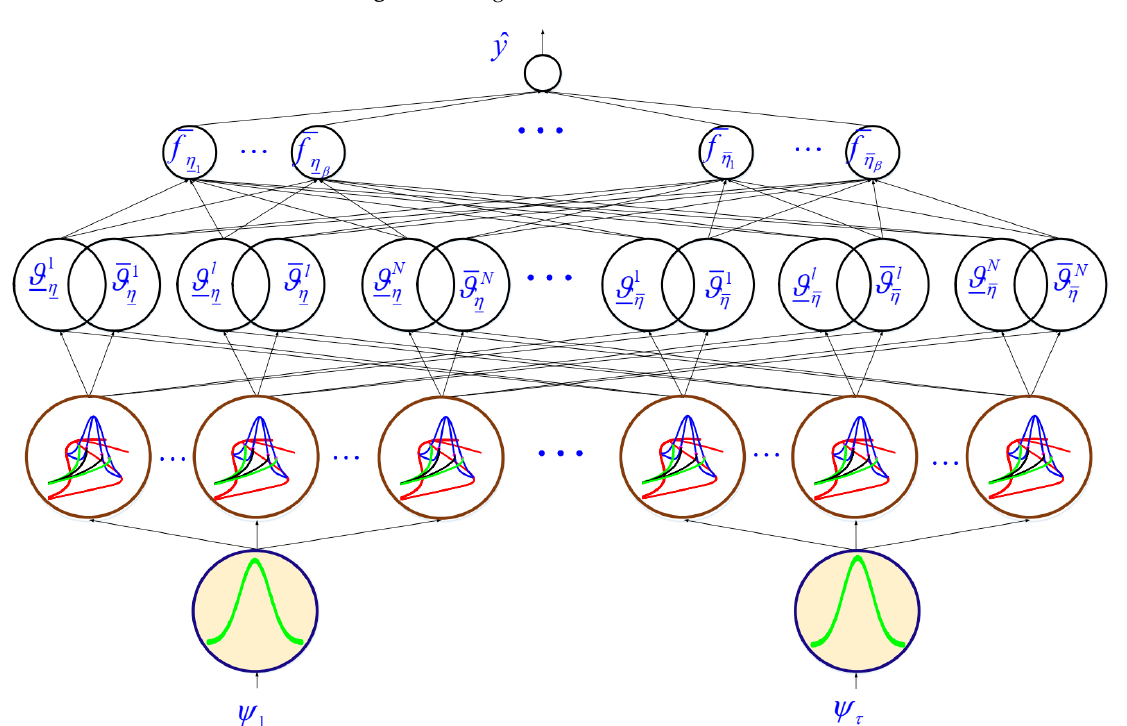
Figure 5. The detailed diagram of